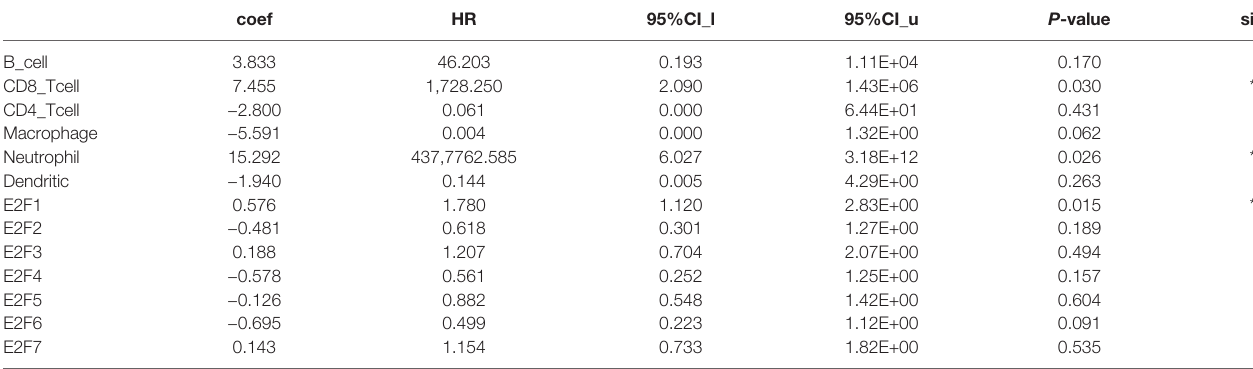
TABLE 4 | The cox proportional hazard model of CXC chemokines and six tumor-in fi ltrating immune cells in PAAD (TIMER). coef HR 95%CI_l 95%CI_u P -value